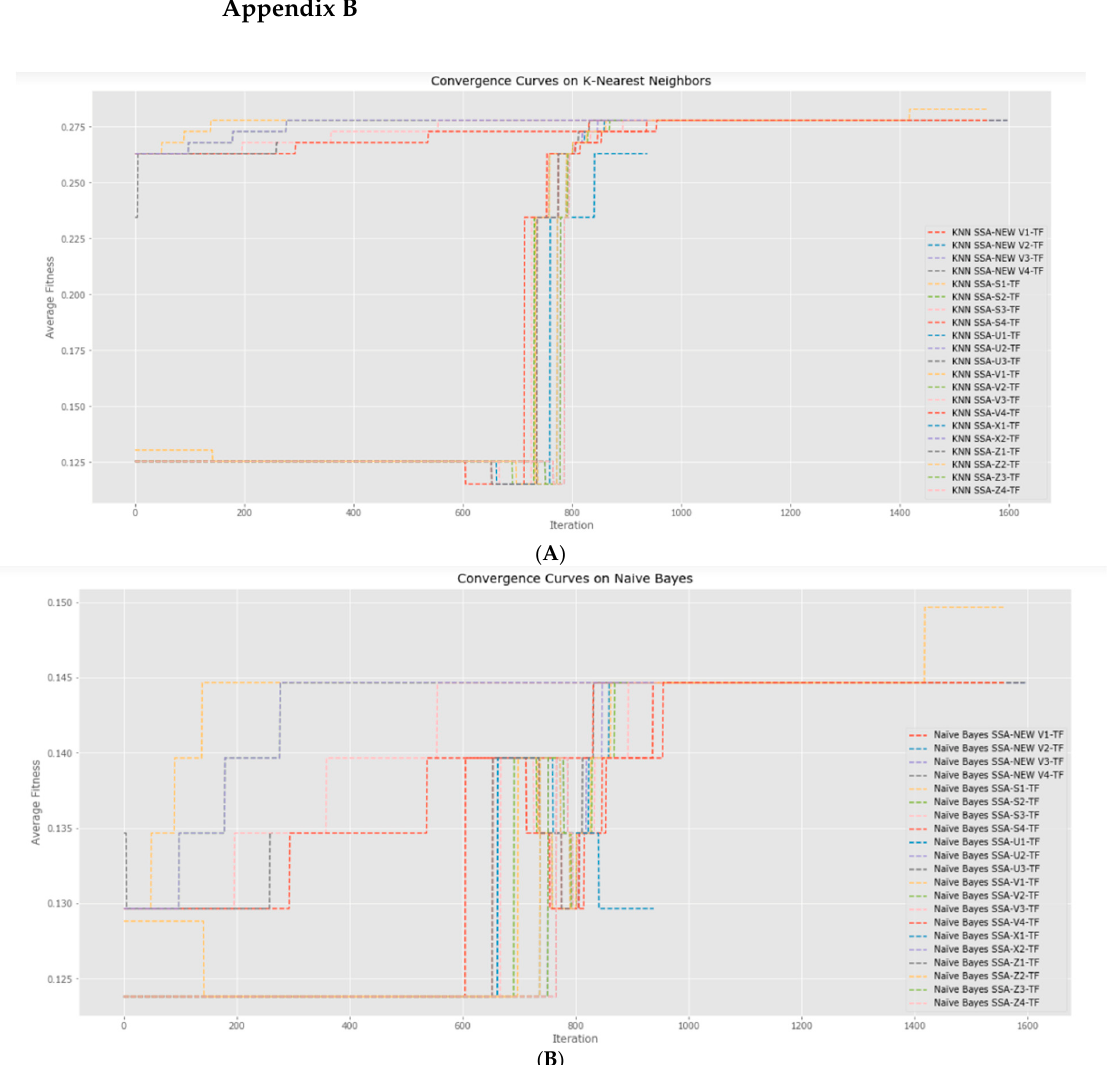
( C ) Figure A1. The average fitness results obtained were based on the convergence curve for the SSA- TF algorithm using the KNN ( A ), naive Bayes ( B ) and SVM ( C ) algorithms.